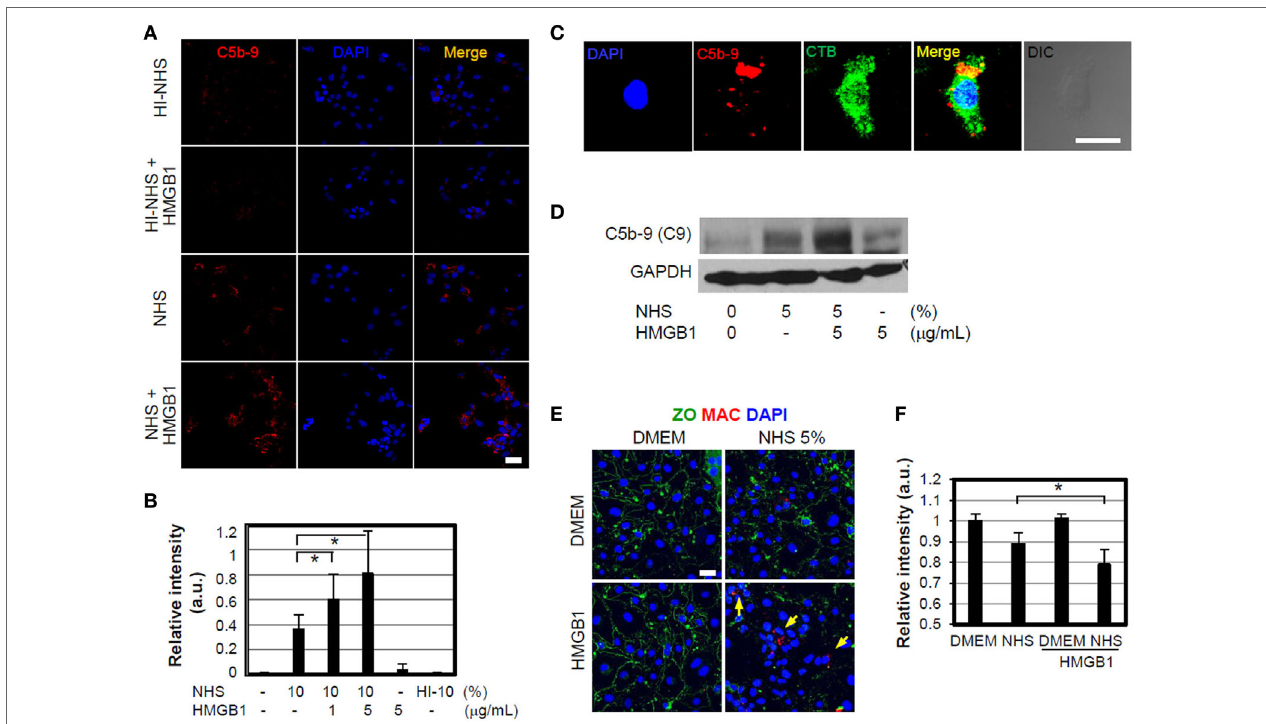
FigUre 4 | High-mobility group box 1 (HMGB1)-mediated membrane attack complex (MAC) formation and its effect to cell signaling. (a,B) MEFs were cultured in DMEM containing 10% normal human serum (NHS) in the presence or absence of 1 µg/ml HMGB1 for 1 h at 37°C. Sublytic MAC proteins were stained using anti-C5b-9 antibody (Ab) (red) and observed by confocal microscopy. Blue: DAPI. Heat-inactivated (HI) NHS was used. Scale bar, 10 µm (a) . MEFs were incubated with 10% NHS in the presence of different concentrations of HMGB1, and then the mean relative intensity of fluorescence of 10 visual fields was calculated (B) . Error bars are mean ± SD. * P < 0.05 by Student’s paired t -test. (c) MEFs were cultured in DMEM containing 5% NHS in the presence of 1 µg/ml HMGB1 for 1 h at 37°C. To observe MAC formation, MEFs were fixed and mouse anti-C5b-9 Ab was used for immunofluorescent analysis. Cholera toxin B-FITC (CTB 0.5 µg/ml, Sigma) was utilized to observe the cell membrane lipid raft using confocal microscopy. Scale bar, 10 µm. (D) bEnd.3 cells were cultured in the presence of 5% NHS and/or 5 µg/ml HMGB1 and MAC formation was observed using Western blot analysis. (e,F) MAC formation. bEND.3 cells and LN215 cells were cocultured and incubated with DMEM containing 5% NHS in the presence or absence of 5 µg/ml HMGB1 for 16 h, and the alteration of tight junction (green line) and sublytic MAC deposition (red fluorescence, arrow) was observed by using confocal microscopy. Anti-ZO-1 Ab and anti-C5b-9 Abs were used for the study. Scale bar = 10 μ m (e) . The mean relative intensity of fluorescence of six visual fields of zonal occluding (ZO) was calculated (F) . Error bars are mean ± SD. * P < 0.05 by Student’s paired t